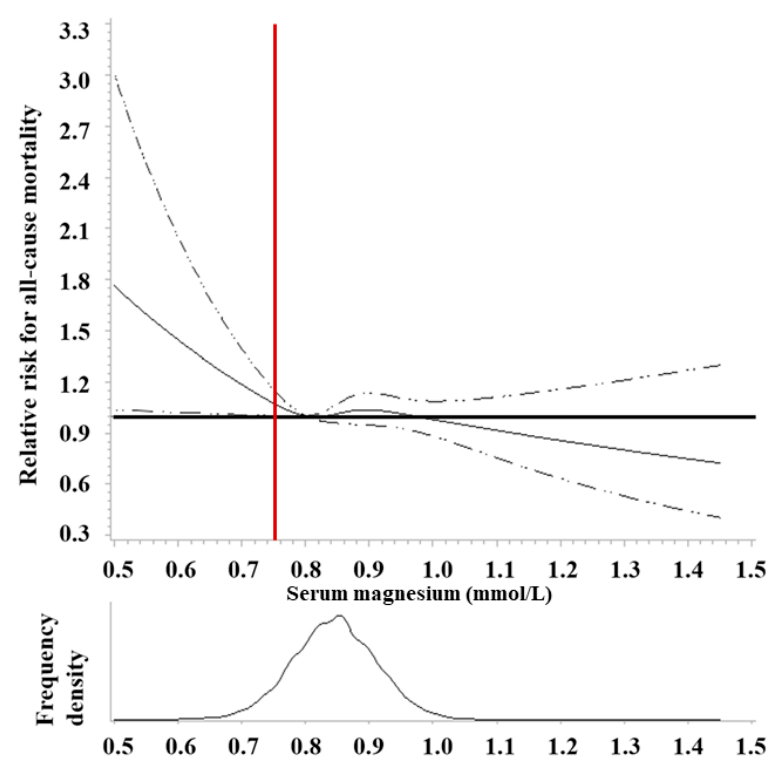
Figure 6. Adjusted hazard ratios of serum magnesium with all-cause mortality in the US adult population (NHANES I 1971–2011). The solid curve is HR calculated by restricted cubic splines with knots at serum Mg levels of 0.73, 0.82, 0.87, and 0.96 mmol/L, a reference HR = 1 set at 0.80 mmol/L, and adjusted using weighted Cox regression model for age, sex, race/ethnicity, education, family income, smoking, alcohol, physical activity, BMI, history of diabetes, hypertension, and vitamin and/or mineral supplement uses. From [190]. Vertical red line indicates magnesium depletion cutoff, i.e., serum Mg concentration <0.75 mmol/L, used in setting DRI [46].